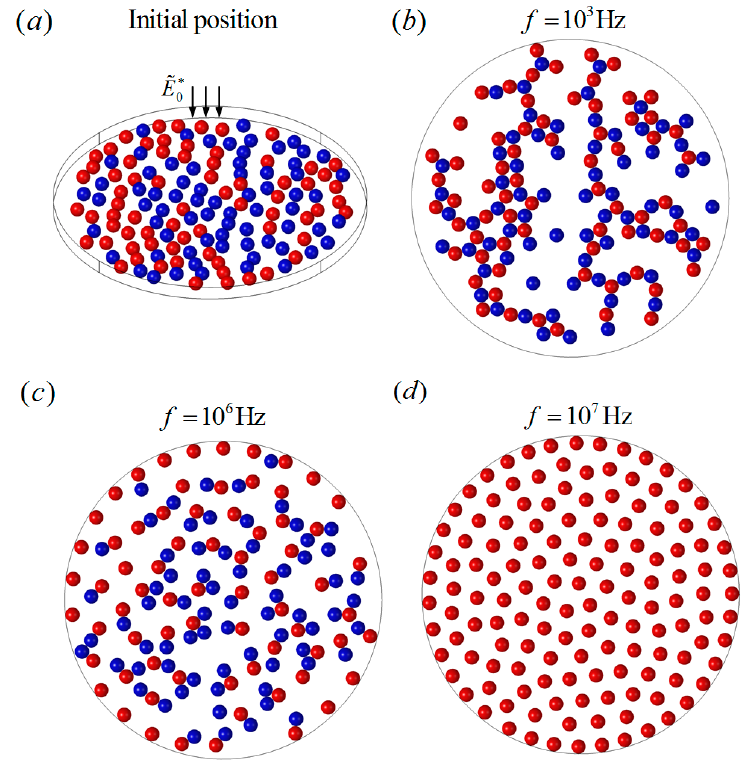
Figure 10. The DEP interactions of randomly distributed particles on a bounded circular plane chip under a perpendicular AC field 0.02 E ∗ = with different frequencies. ( a ) The initial random distribution of 140 particles; ( b ) the particle chains when 3 10 Hz f = ; ( c ) the particle chains when 6 10 Hz f = ; ( d ) the uniform distribution when 7 10 Hz f = .